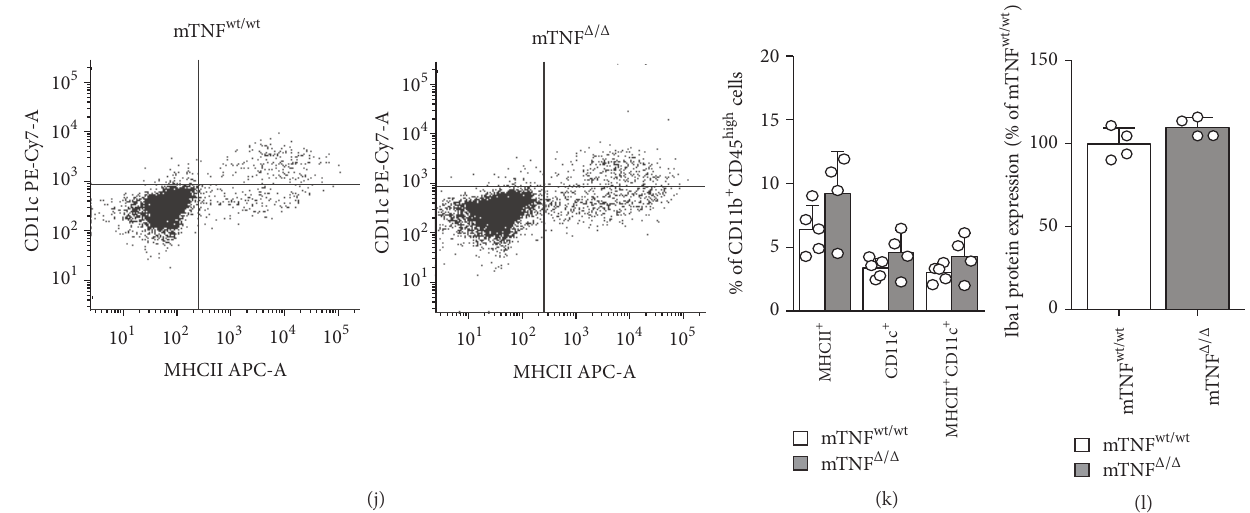
Figure 5: Flow cytometric analysis of the activation state of microglia and infiltrating cells 3 days after SCI. (a–c) Number of CD11b + CD 45 dim microglia (a) and CD11b + CD 45 high cells (b) and percentages of microglia and infiltrating cells (c) within the lesion and in the perilesion area 3 days after SCI. (d) Representative histograms of MHCII expression on CD11b + CD 45 low microglia and CD11b + CD 45 high cells located in the lesions of mTNF wt / wt and mTNF Δ/Δ mice 3 days after SCI. (e, f) The number of MHCII + CD11b + CD 45 high cells (e) and MFI for MHCII (f) were comparable between mTNF wt / wt and mTNF Δ/Δ mice. (g) Representative histograms of CD11c expression on microglia and infiltrating cells located in the lesions of mTNF wt / wt and mTNF Δ/Δ mice 3 days after SCI. (h, i) The number of CD11c + CD11b + CD 45 high cells (h) and MFI for CD11c expression (i) were comparable between mTNF wt / wt and mTNF Δ/Δ mice. (j) Representative dot blots comparing CD11c expressions on MHCII + CD11b + CD 45 high cells in mTNF wt / wt and mTNF Δ/Δ mice 3 days after SCI. (k) Percentages of MHCII + , CD11c + , and MHCII + CD11c + cellsinthelesionarea. 𝑛 = 4 -5 mice/group.(l)WesternblotanalysisforIba1proteinexpression3daysafterSCI.Dataarenormalizedto 𝛼 -actin protein expression ( 𝑛 = 4 /group). Results are presented as mean ± SD, ∗ 𝑝 < 0.05 , ∗∗ 𝑝 < 0.01 , Mann–Whitney and Wilcoxon matched-pairs signed rank tests.